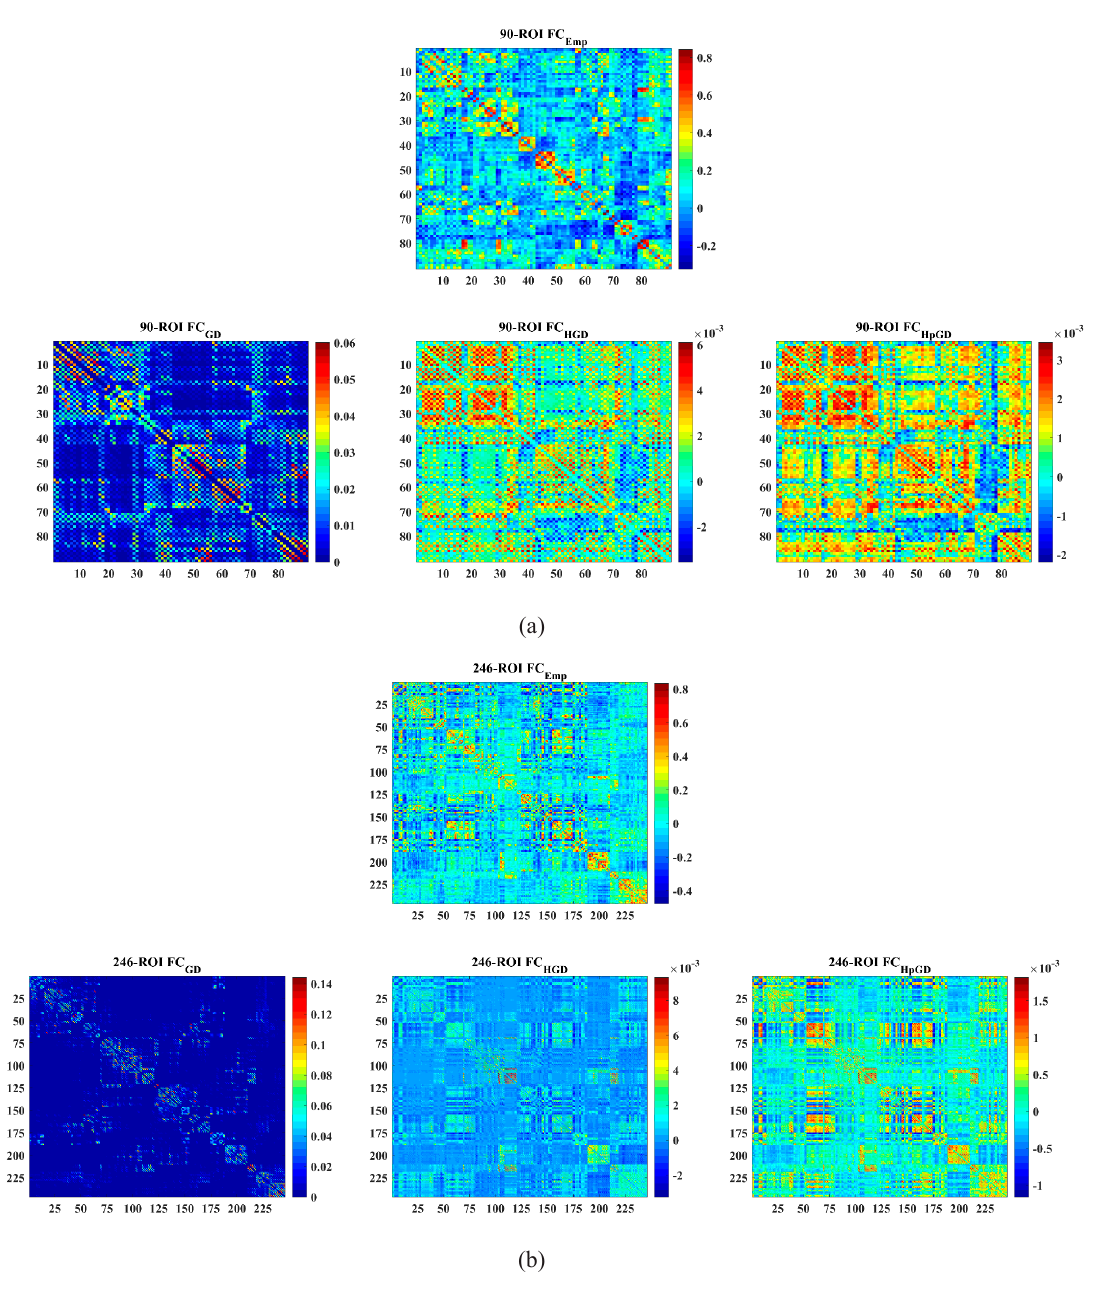
Figure 3. The mean empirical FC matrices vs. the mean predicted FC matrices by the three models. ( a ) The 90 ROIs dataset. Fig. 3 The mean empirical FC matrices vs the mean predicted FC matrices by the three models. (a) 90 ROIs ( b ) The 246 ROIs dataset. (b) 246 ROIs dataset.